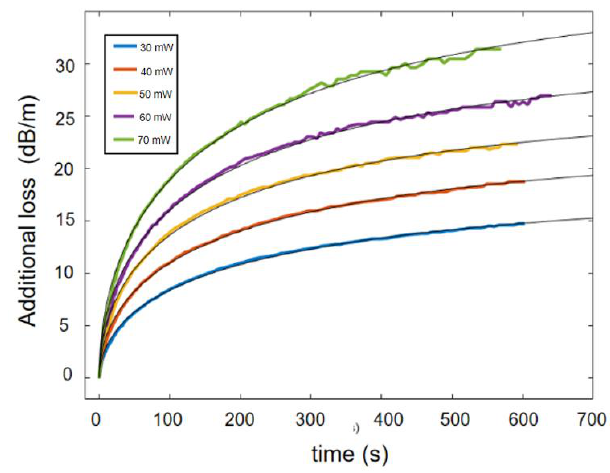
Figure 8. Relationship between core temperature and maximum additional loss. a and b in the figure is the fitting parameter.